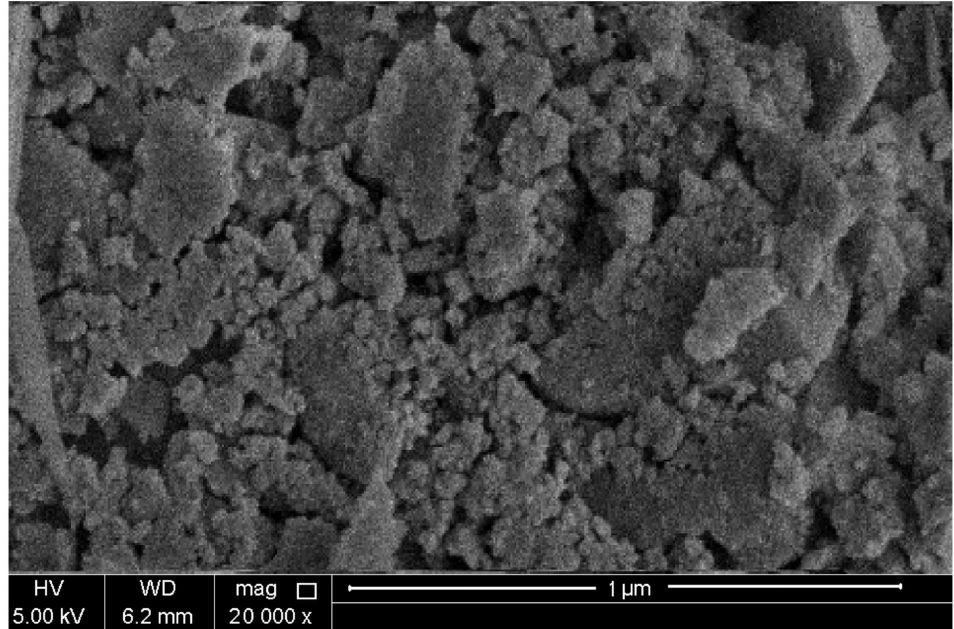
Figure 5. SEM image of the produced